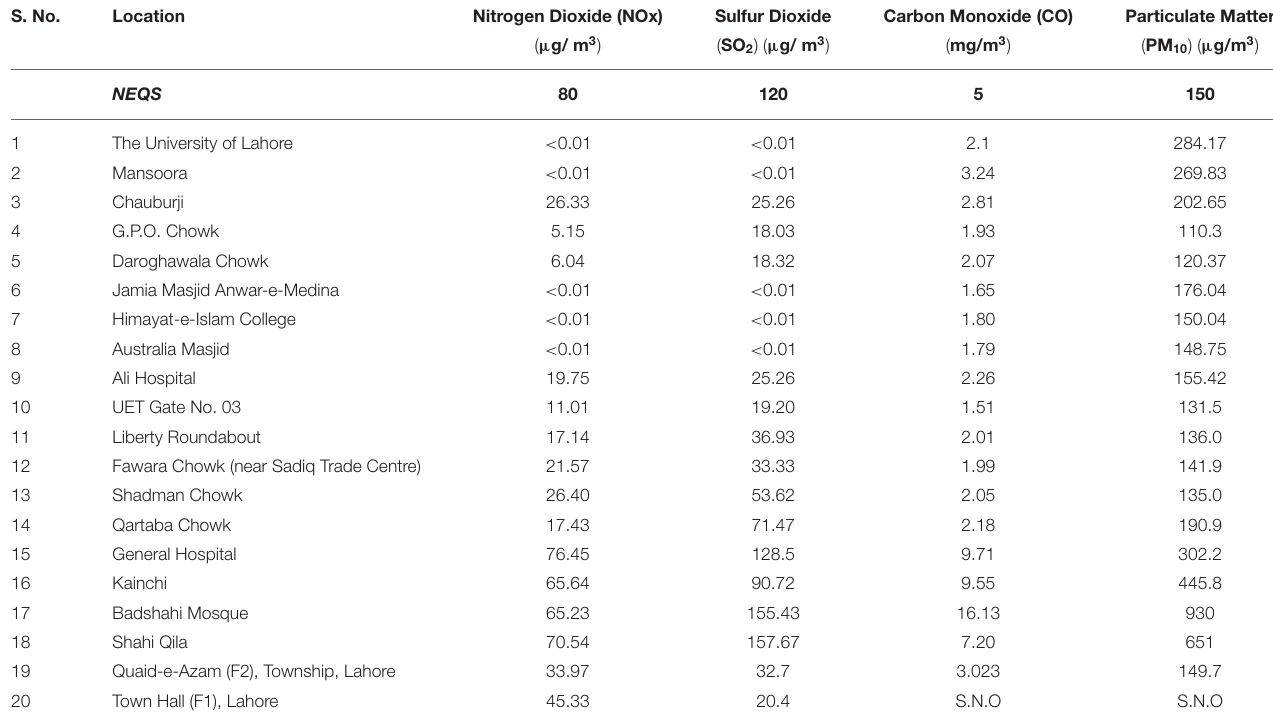
TABLE 3 | Concentration of air pollutants in the built-up area of Lahore.